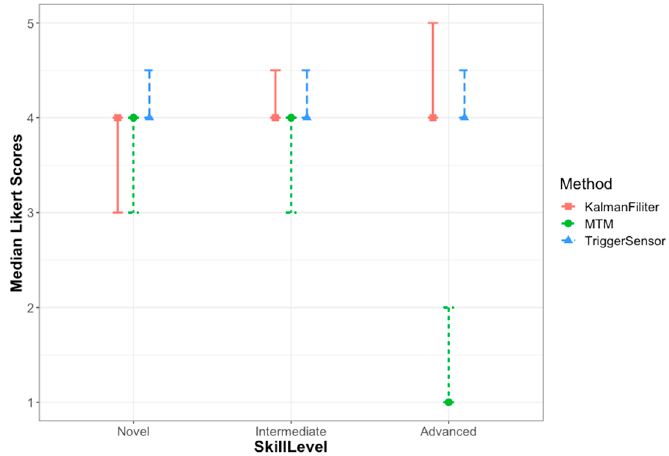
Figure 9. Median preference scores of participants in three skill level groups and for three handover prediction models.